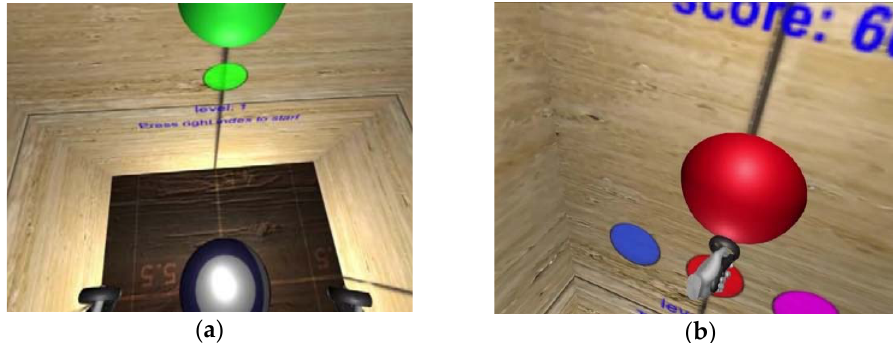
Figure 2. Virtual reality exposure therapy for claustrophobia with an added CR task. ( a ) Before the start of the gamified attention task; ( b ) during the gamified attention task.